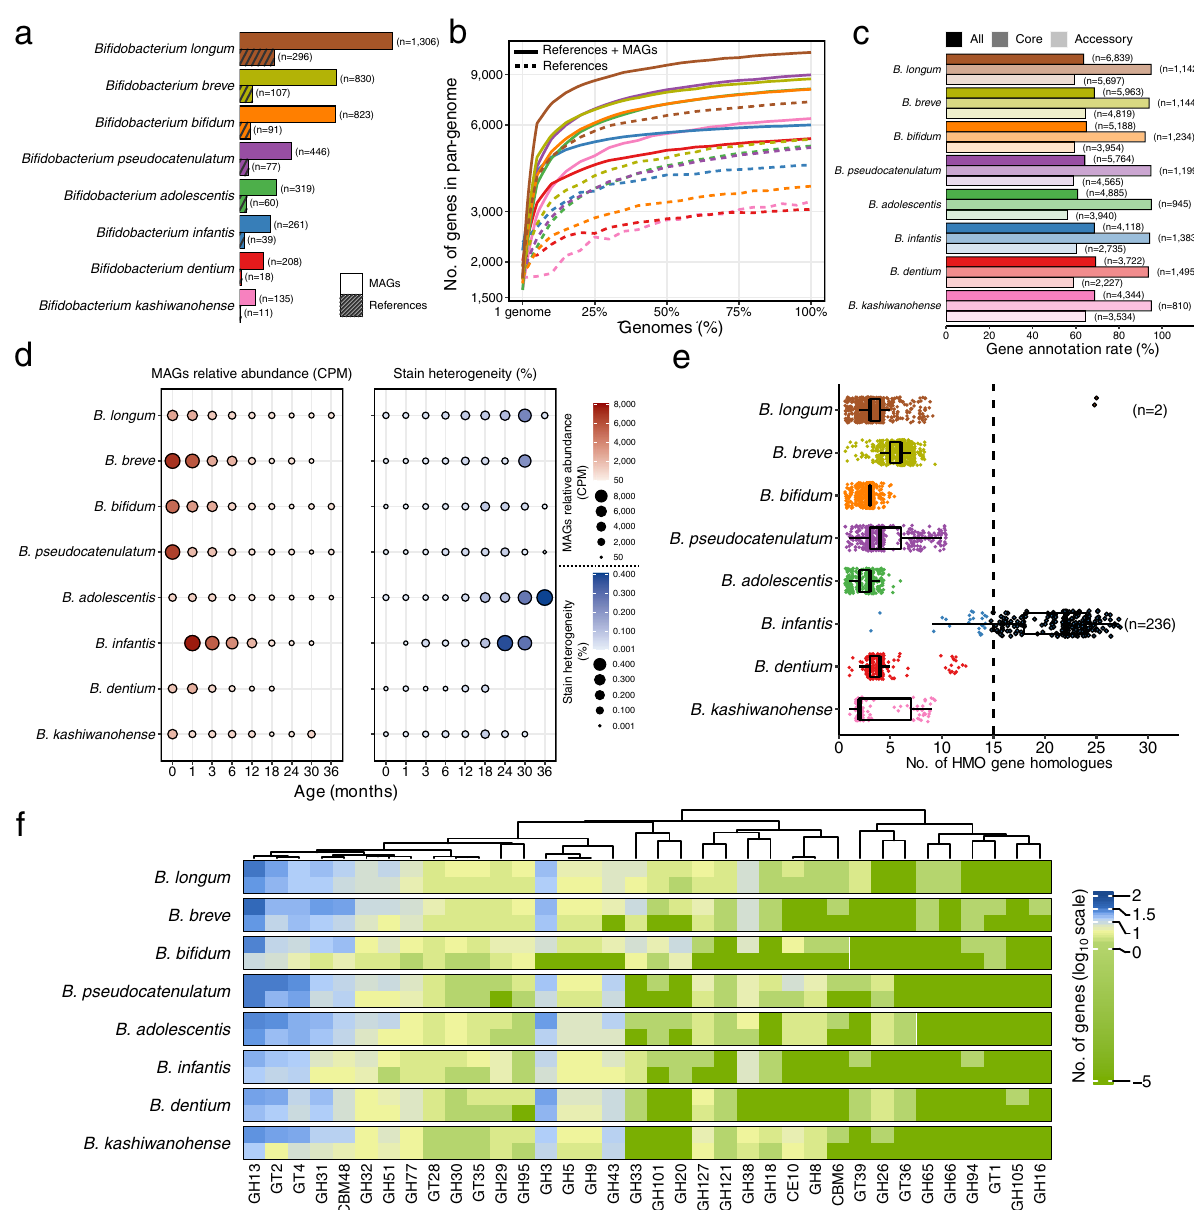
Fig. 4 | Characterization of key early-life Bi fi dobacterium spp. from ELGG cat- alog. a The number of genomes strati fi ed by MAGs and referencegenomes. b The pan-genomeplotrepresentedbytheaccumulatednumberofgenesasafunctionof the number of genomes strati fi ed by MAGs and reference genomes. c The rate of functional annotation across databases of COGs, KEGG, GOs, ECs, and CAZy for each species strati fi ed by core and accessory genes. The number in parentheses indicates the number of genes with functional annotation. d Dynamics of the relative abundance and strain heterogeneity of MAGs in response to the age of